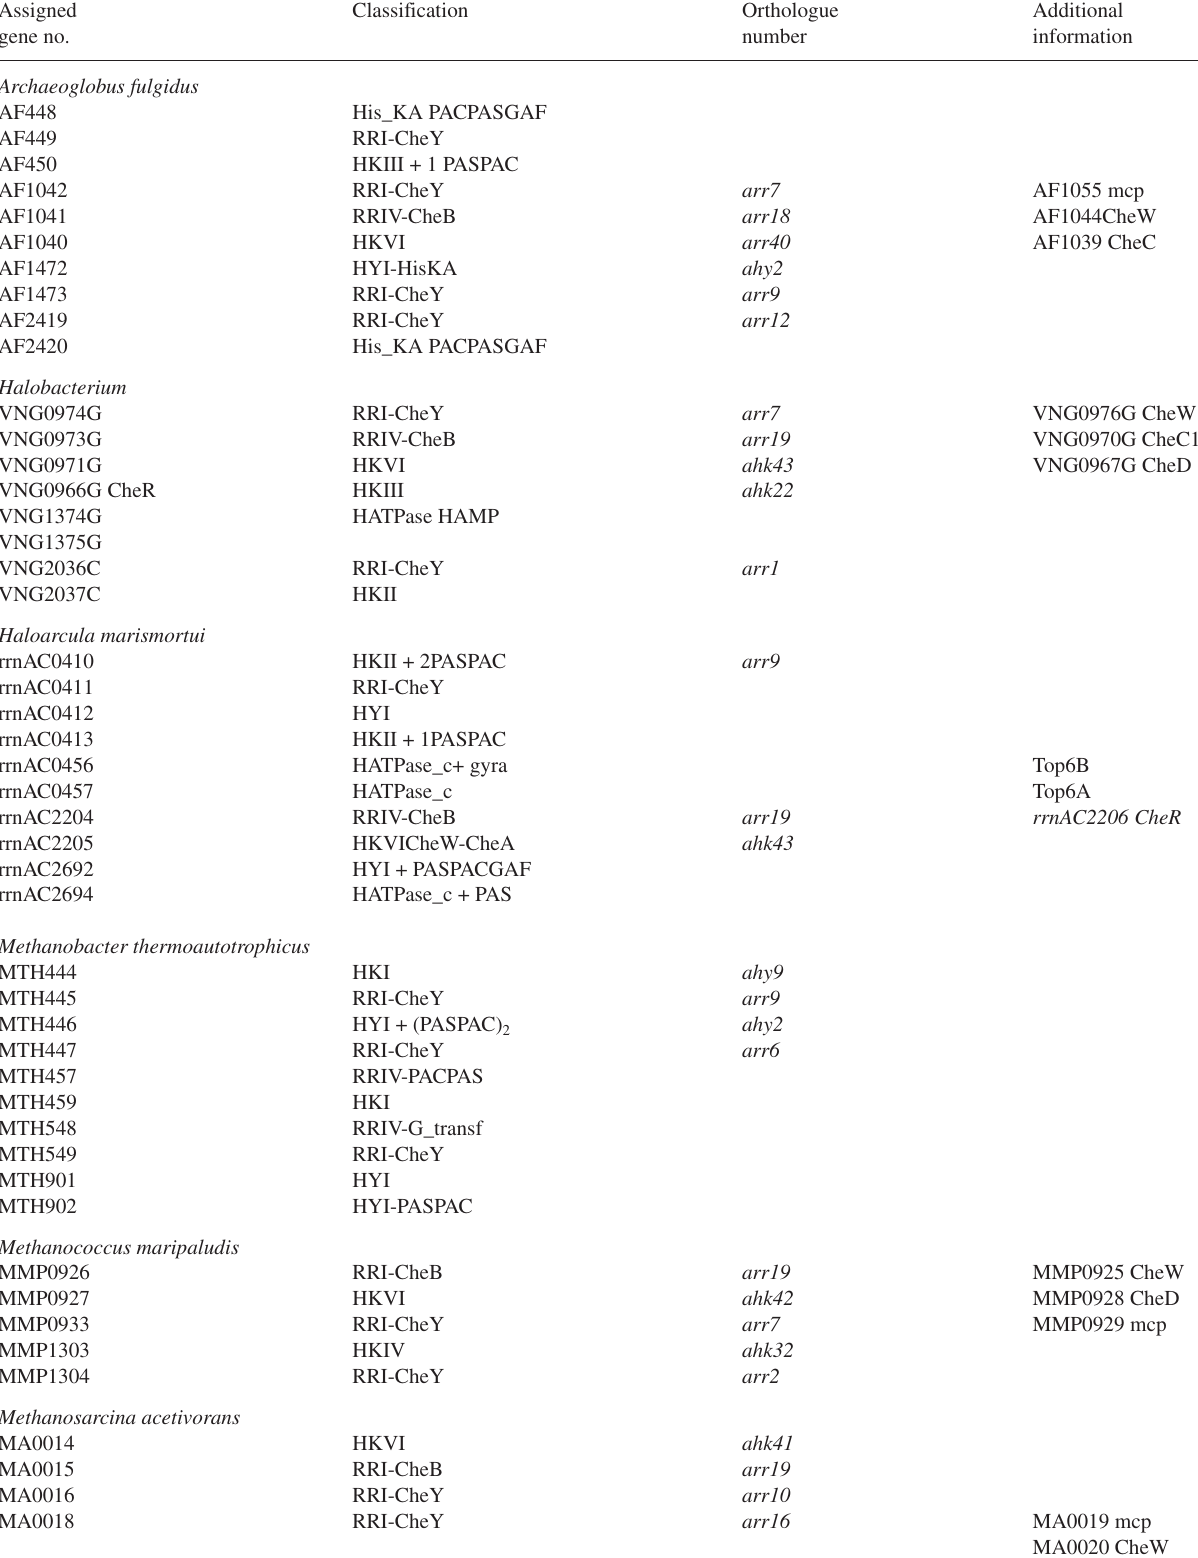
Table A2. Closely linked genes that may be part of operons.